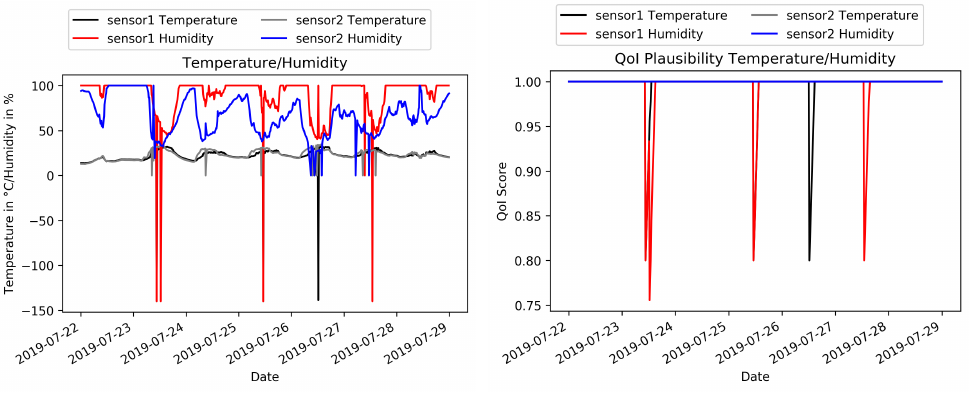
Figure 8. Aarhus CityProbe sensor’s data and